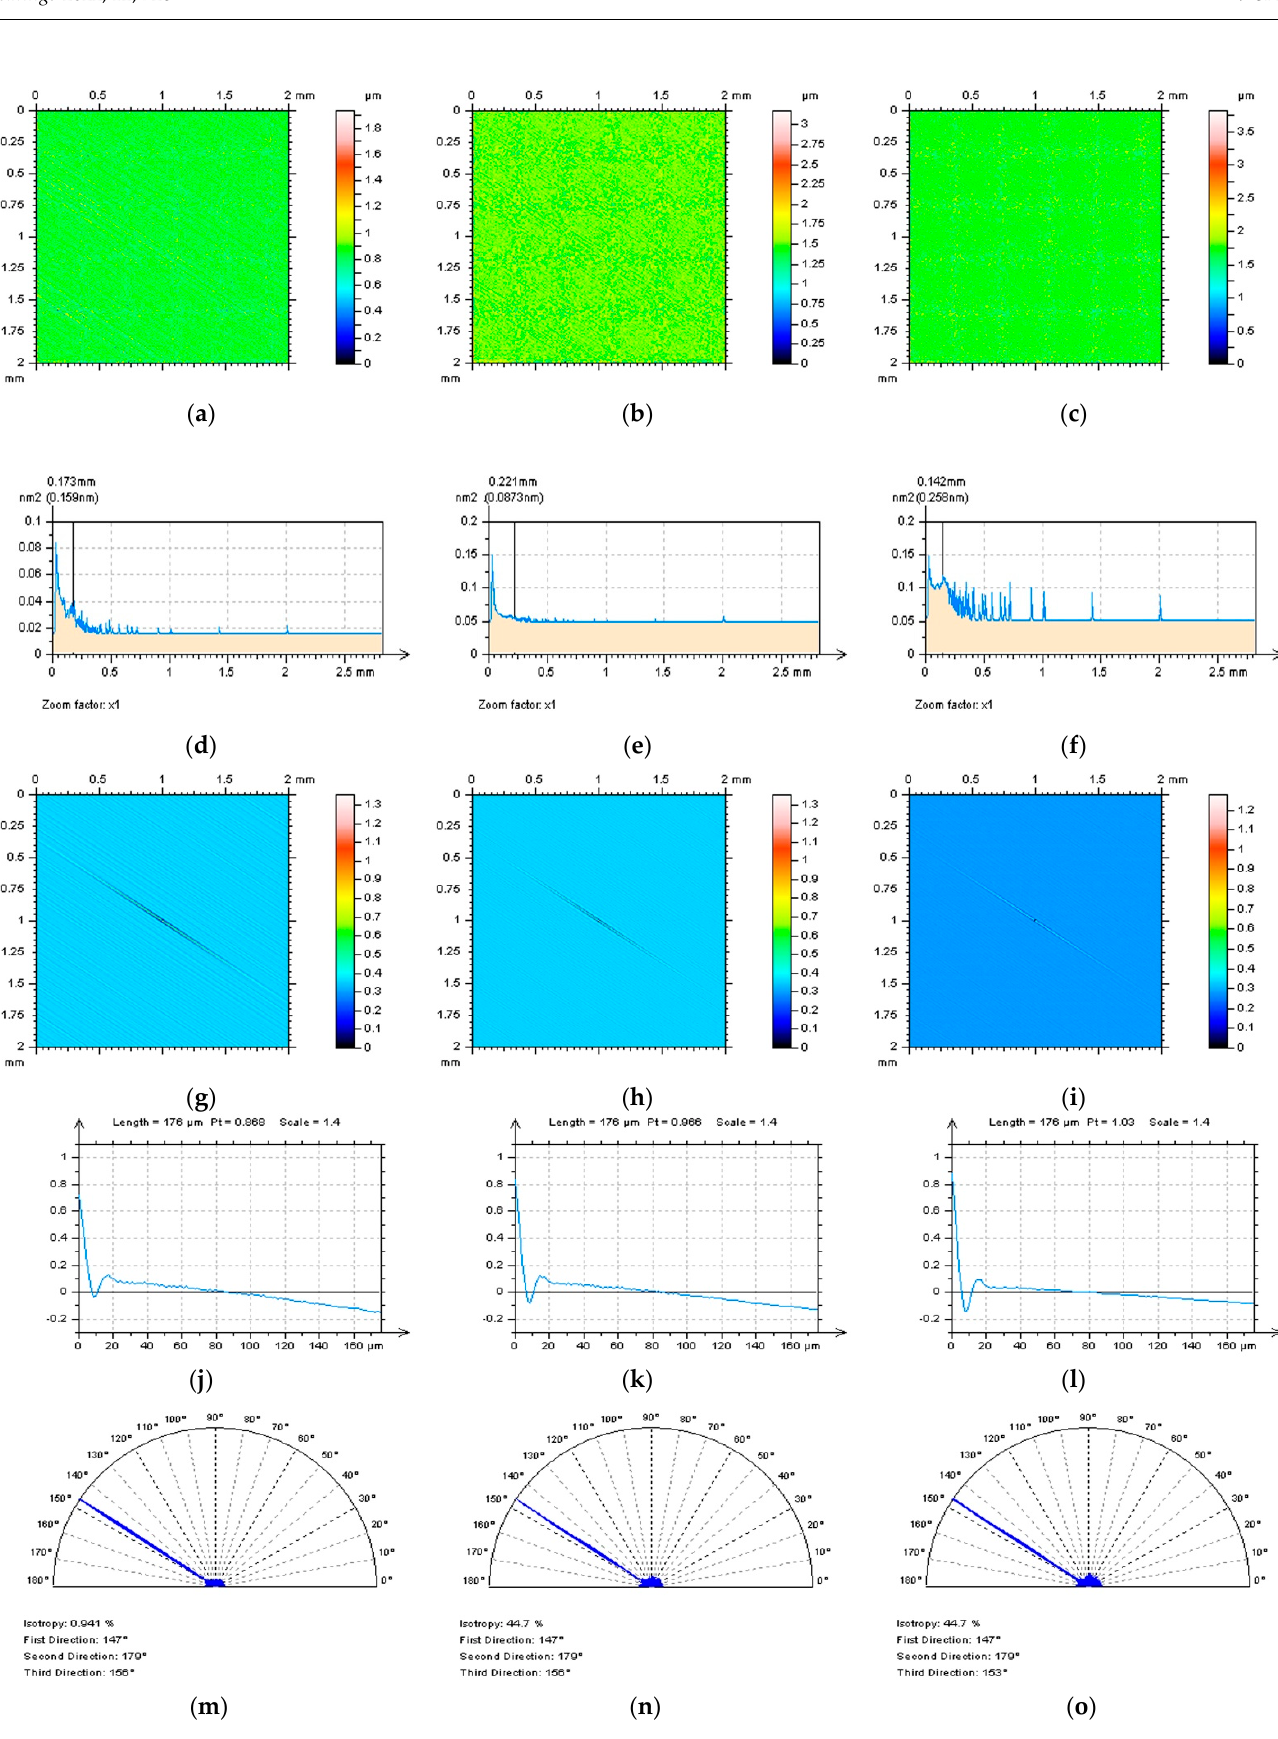
Figure 4. Contour map plots ( a – c ) of HFNS received from ground surface after application of GF (left column), SF (middle) and MDF (right column), their PSDs ( d – f ), ACFs ( g – i ), extraction of ACFs based on direction of the treatment traces ( j – l ) and TD graphs ( m – o ), respectively, cut–off = 0.025 mm.